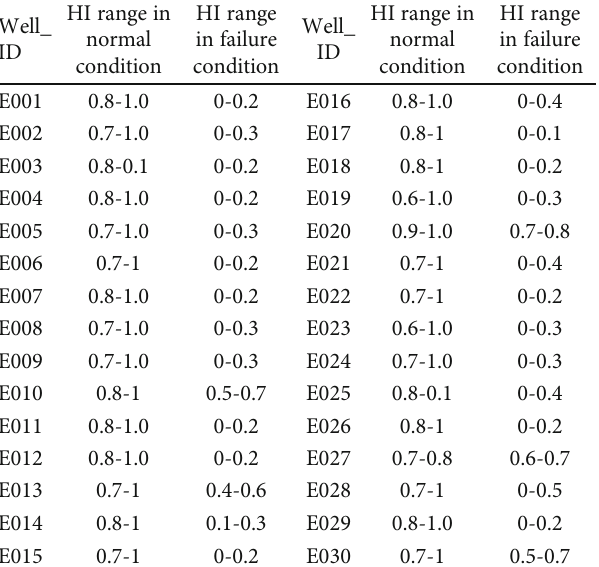
Table 5: HI range of 30 failure